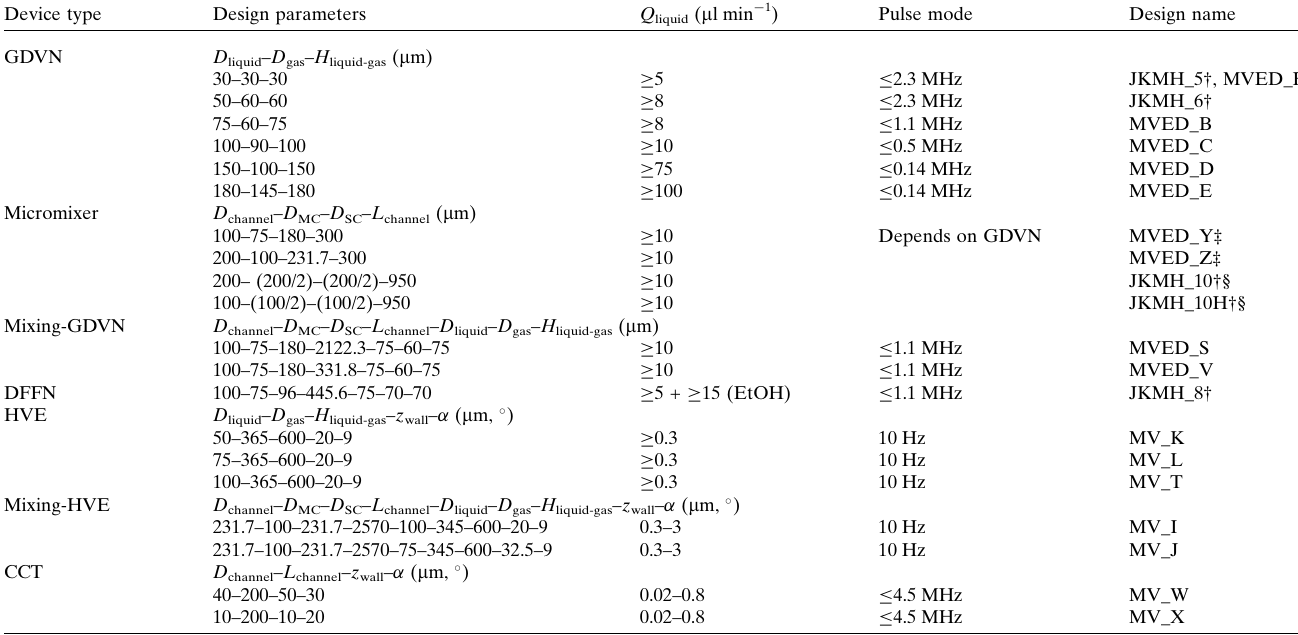
Table 2 List of microchannel design parameters for the 2PP-3D printed liquid sample injection devices with an indication of required liquid flow rates (in m l min (cid:4) 1 ) for stable operation and compatible pulse operation modes (intra-train pulse repetition rates). The denoted parameters for GDVNs describe the liquid orifice diameter D liquid , the gas orifice diameter D gas and the distance between these two orifices H liquid-gas . Mixing devices are further described by the diameter of the mixing channel D channel , the diameter of the main channel (sample inlet) D MC , the diameter of the side channel (reactant inlet) at the mixing initiation region D SC and the mixing channel length L channel . HVEs and CCTs for electrospray purposes are further described with their wall thickness at the tip z wall and the angle of the cone. This list and the referenced designs can be found online in our corresponding GitHub repository, https://github.com/flmiot/EuXFEL-designs. Device type Design